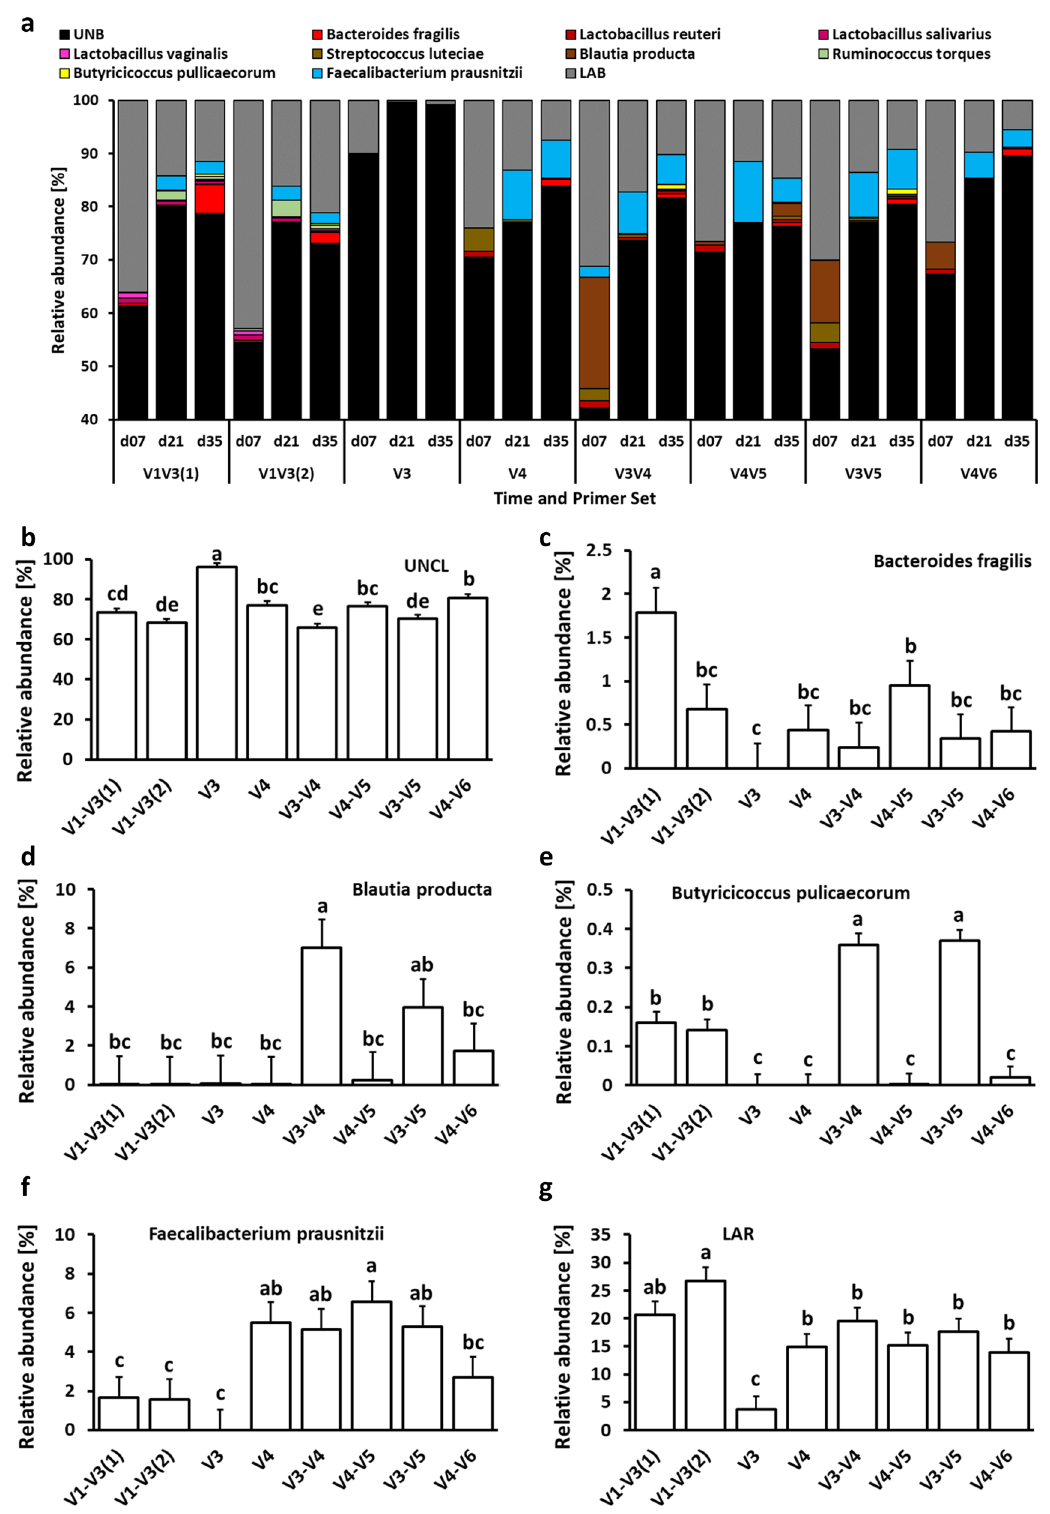
Figure 5. Changes in relative bacterial abundance (%) in chicken cecal content at species level. (a) Taxonomic profile of chicken cecal microbiota. Effect of primer sets on the relative abundance of (b) unclassified bacteria (UNCL), (c) Bacteroides fragilis , (d) Blautia producta , (e) Butyricicoccus pulicaecorum, (f) Faecallibacterium prausnitzii , and (g) low abundance reads (LAR). Only significant ( P < 0.05) data are shown and only first 6 species with the highest abundance are shown. Different letters denote statistically significant ( P < 0.05) differences between primer